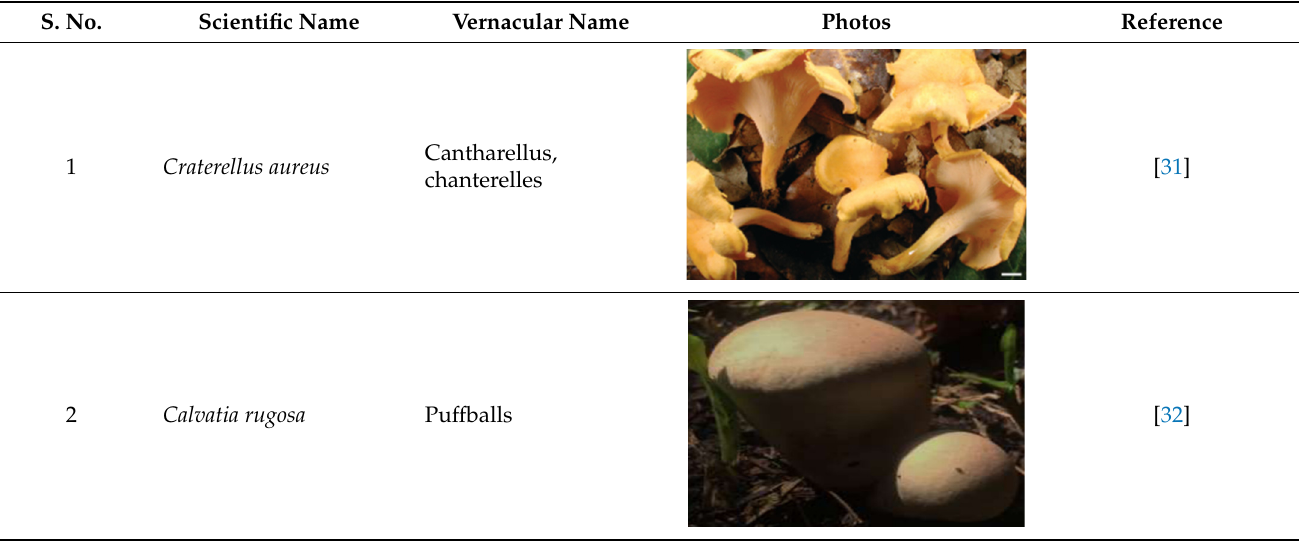
Figure 1. Review research methodology. Table 1. Types of edible mushrooms.